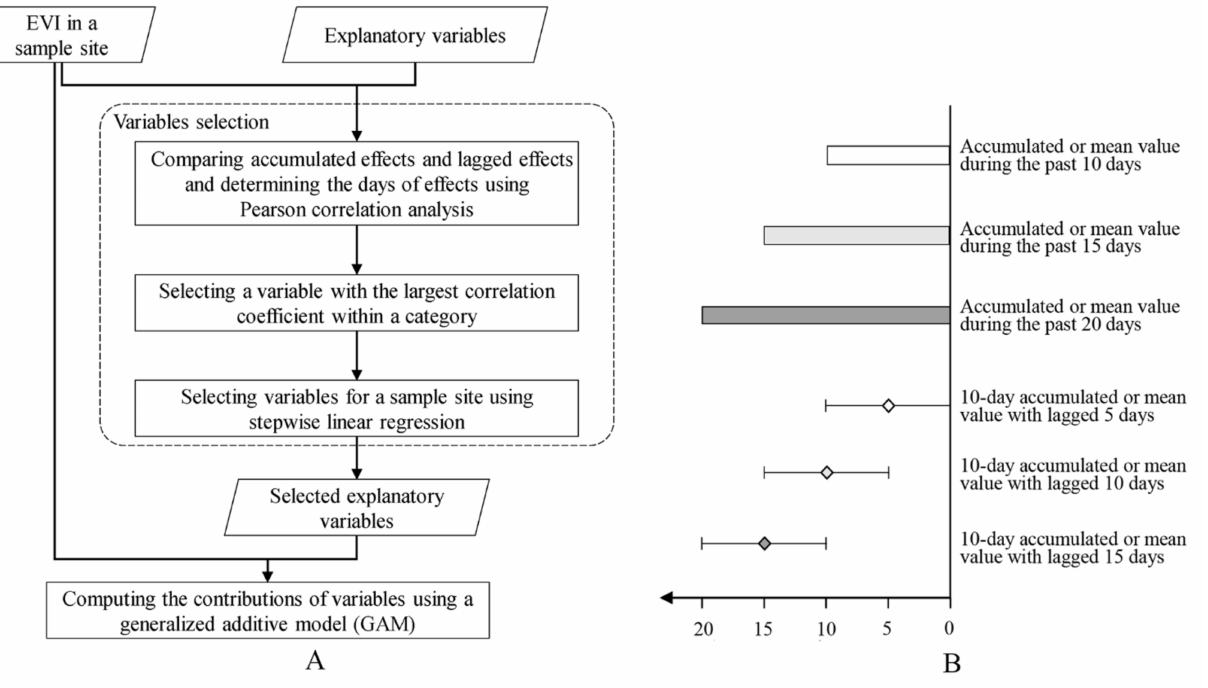
Figure 3. ( A ) Exploration processes of potential variables and their contributions on vegetation variations; ( B ) illustration of accumulation periods (climatic variables) and time lags (climatic variables vs.